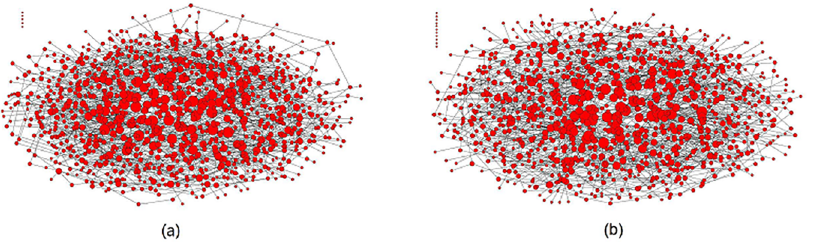
Fig 5. Interaction relation networks formed by all players in the stationary regime of evolutionary dynamics under (a) random interaction and (b) high-degree preferenceinteraction. Defect temptation and upper-bound are set to b = 1.7 and W = 16,